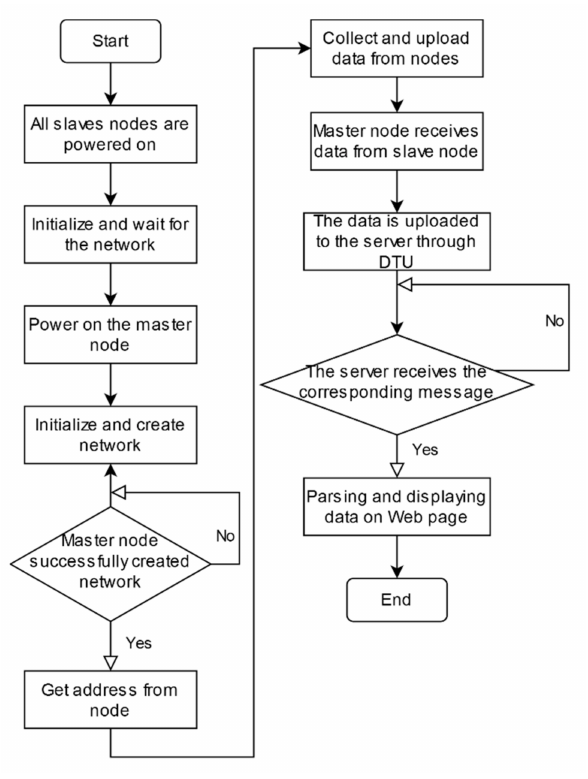
Figure 7. Network communication